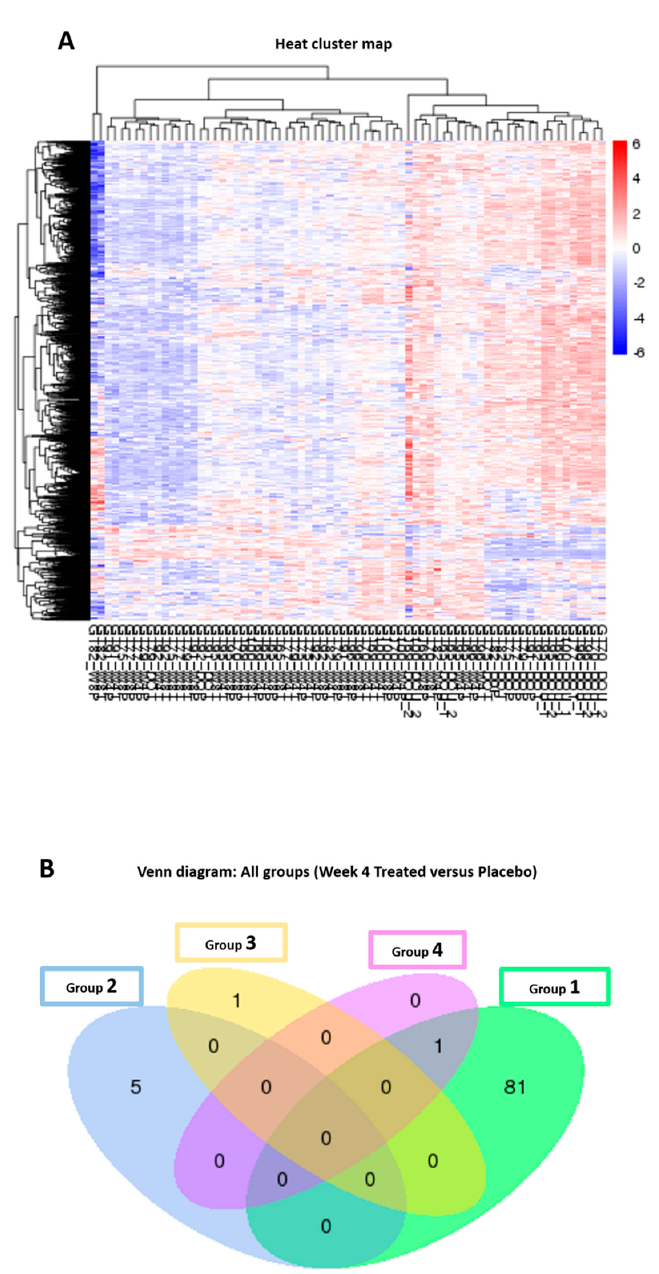
Figure 15. mRNA-sequencing results (Cluster analysis and Venn diagram). ( A ) Cluster analysis of differential expression genes. Hierarchical clustering analysis was carried out with the log 10 (FPKM + 1) of union differential expression genes of all comparison groups under different experimental conditions. Highly expressed genes are indicated in red, and genes with low expression are indicated in blue. Samples were ordered from those with lowest expression levels on the left to highest expression levels on the right side. ( B ) Venn diagrams to illustrate the number of common and unique differential expression genes among comparison groups. Group 1 had the greatest number of differentially expressed genes compared to all other groups.